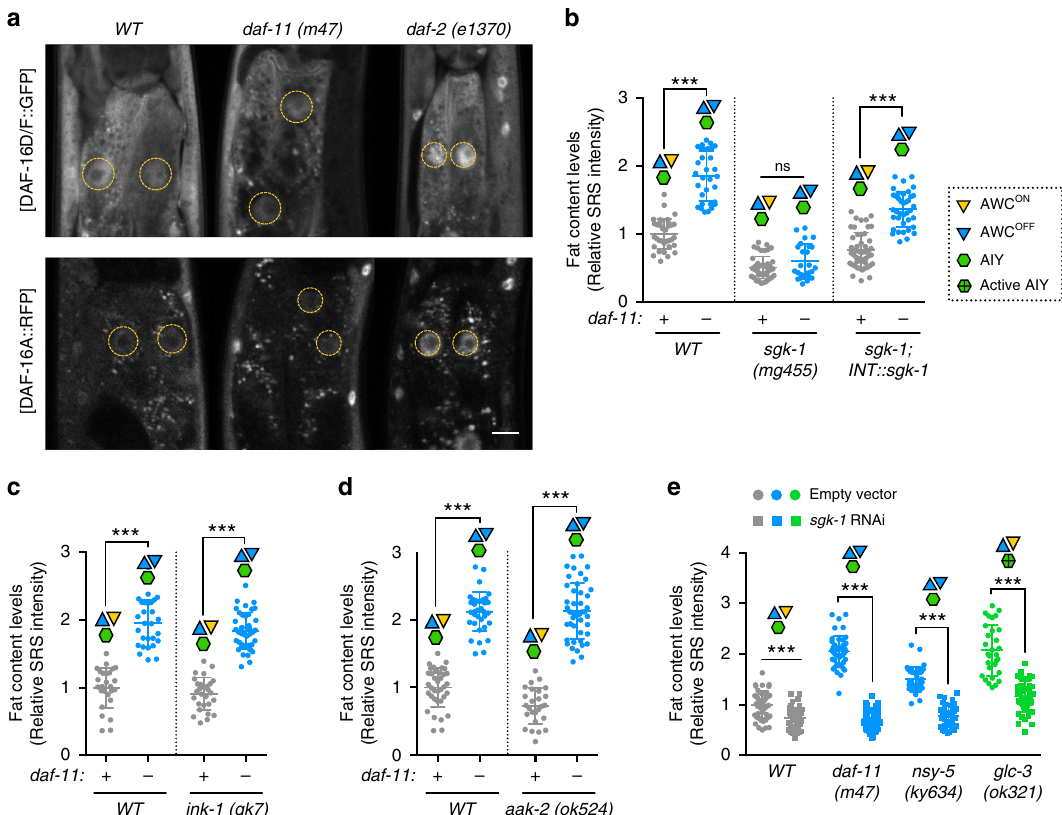
Fig. 5 SGK-1 kinase regulates fat metabolism in response to olfactory signaling. a Neither DAF-16A nor DAF-16D/F nuclear localization is strongly enhanced in the daf-11 mutants, as it does in the daf-2 mutants. Scale bar = 40 μ m, yellow dashed lines circle nuclei of the intestinal cells. b Inactivation of SGK-1 fully suppresses the increased fat storage in the daf-11 mutants. Intestine-speci fi c restoration of sgk-1 rescues the fat storage increase in the daf-11 ; sgk-1 double mutants. Representative SRS images are in Supplementary Fig. 7c. c , d Neither the JNK homolog jnk-1 ( c ), nor the AMPK homolog aak-2 ( d ) affects the fat storage level in WT or in the daf-11 mutants. Representative SRS images are in Supplementary Fig. 7d, e. e Knockdown of sgk-1 in the daf-11 and nsy-5 mutants, that lack AWC ON neurons, or in the glc-3 mutants with active AIY neurons suppresses the increased fat storage. Representative SRS images are in Supplementary Fig. 7a. For b – e data are mean ± s.d., *** P < 0.001, n.s. not signi fi cant by two-way ANOVA with Sidak ’ s multiple comparison test. Numbers of animals used are listed in Supplementary Data 1. For b – e source data are provided as a Source Data fi